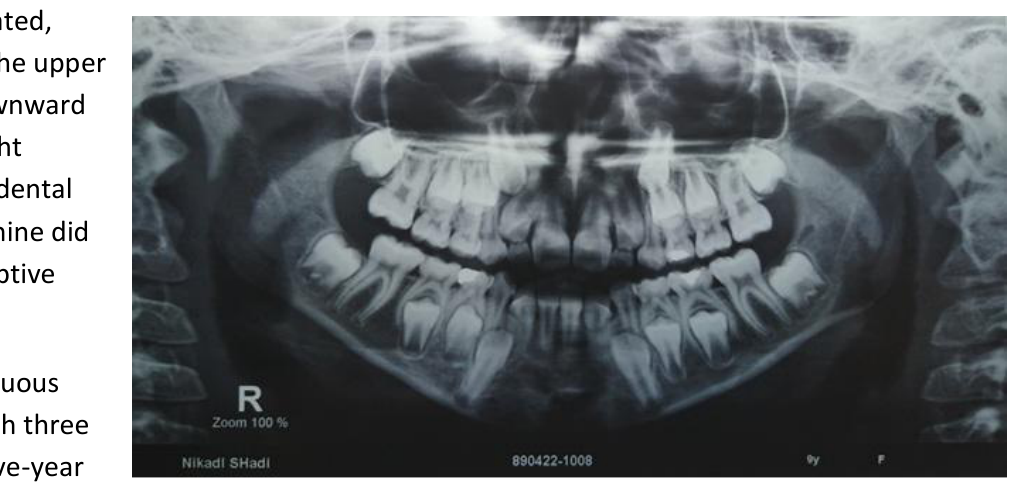
Figure 3. The panoramic radiograph of the patient after two years follow-up at the age of 9.